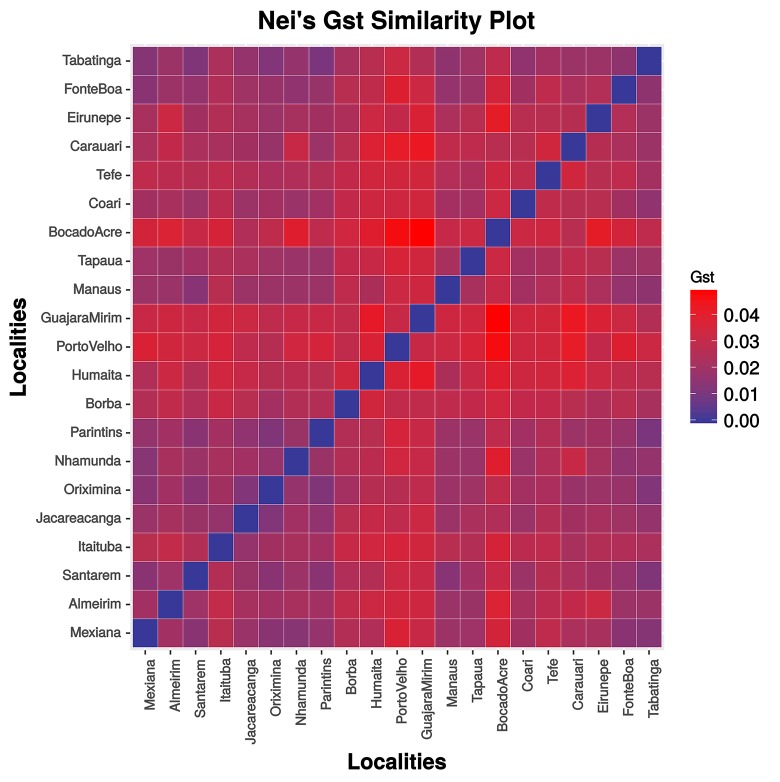
Graphic representation of pairwise Hedrick's GST values.